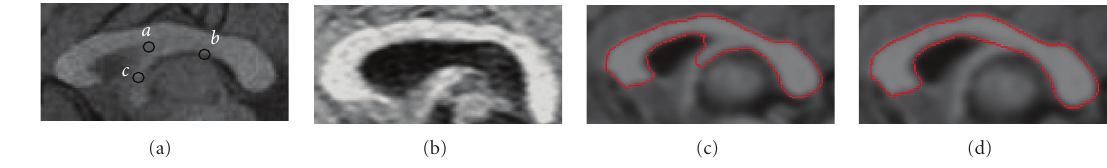
Figure 5: (a) Distinct points around the fornix. (b) The example of disconnected fornix. (c) The result without fornix removal. (d) The result with fornix removal.